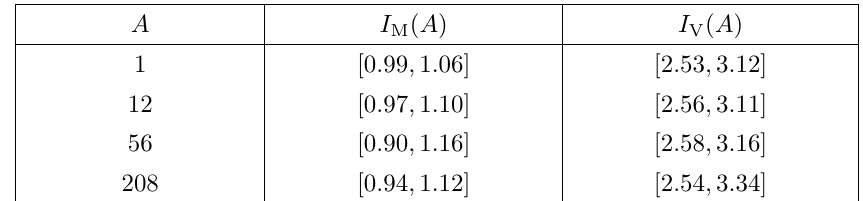
Figure 19 . The distribution of the momentum (left) and total valence (right panel) integrals, eqs. (4.6) and (4.7) respectively, in the variants of the nNNPDF2.0 determination where the cor- responding sum rules have not been explicitly imposed. We show the relative frequency of the momentum and valence integral for three representative nuclei: 12 C, 56 Fe, and 208 Pb. The dashed vertical line indicates the corresponding the QCD expectations, I M ( A ) = 1 and I V ( A ) = 3. The associated 90% CL ranges are reported in table 6.